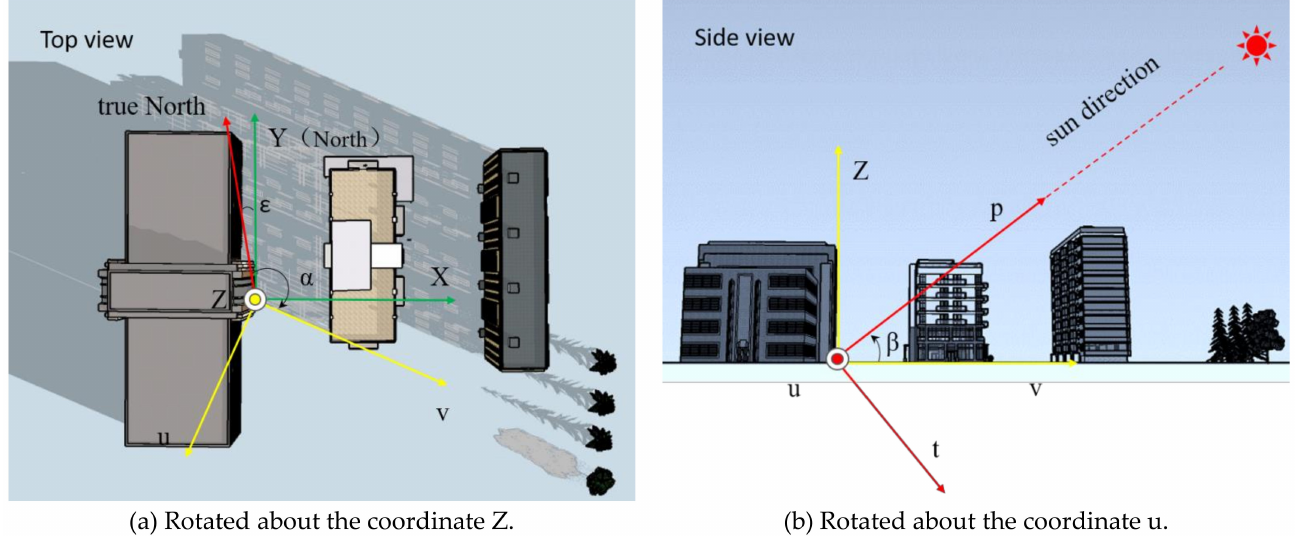
Figure 3. Illumination point identification and axis transform